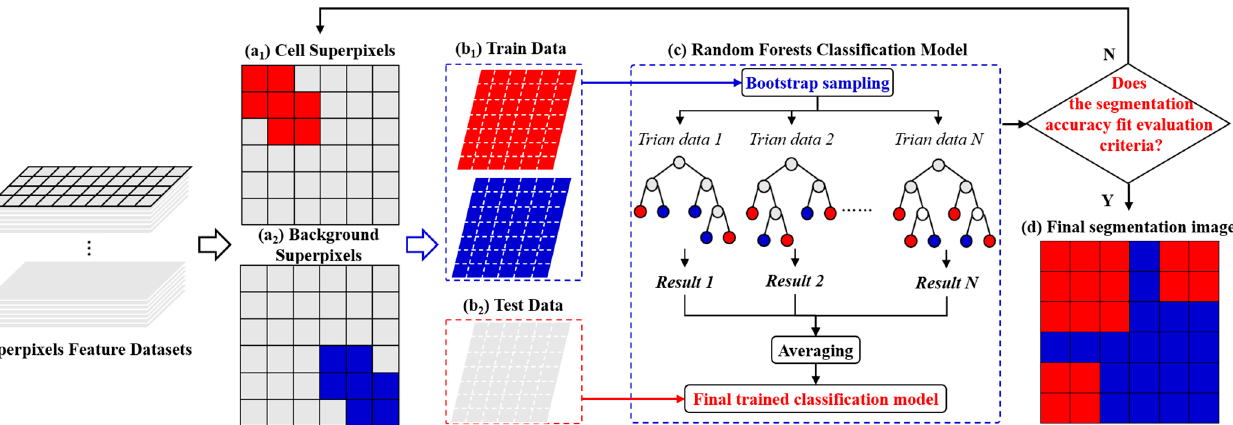
Figure 5. Superpixel feature dataset with the improved Unet model and SLIC algorithm.